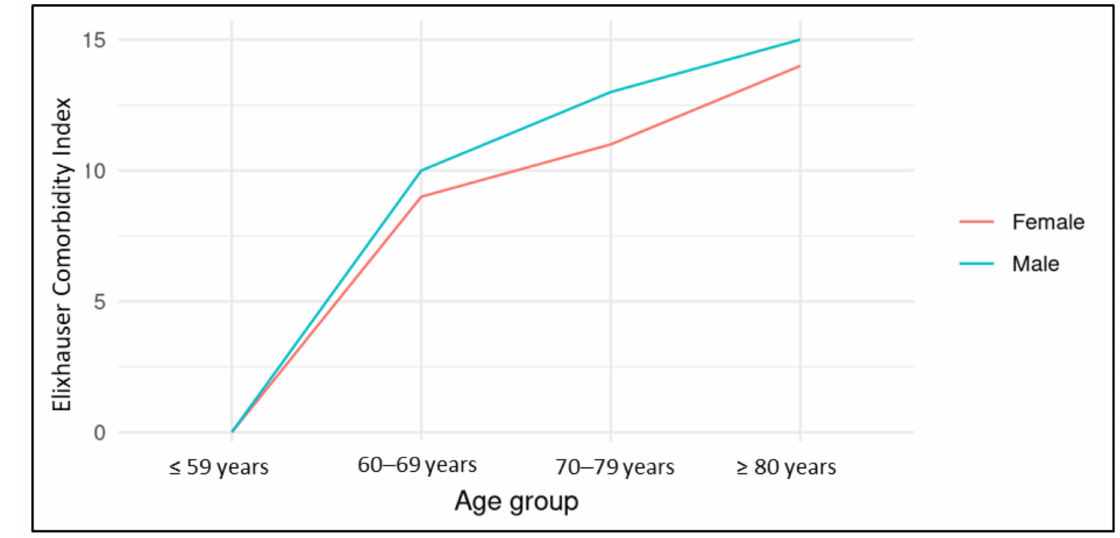
Figure 1. Elixhauser Comorbidity Index (Median) in Dependence of Age. The interaction was not significant ( p =